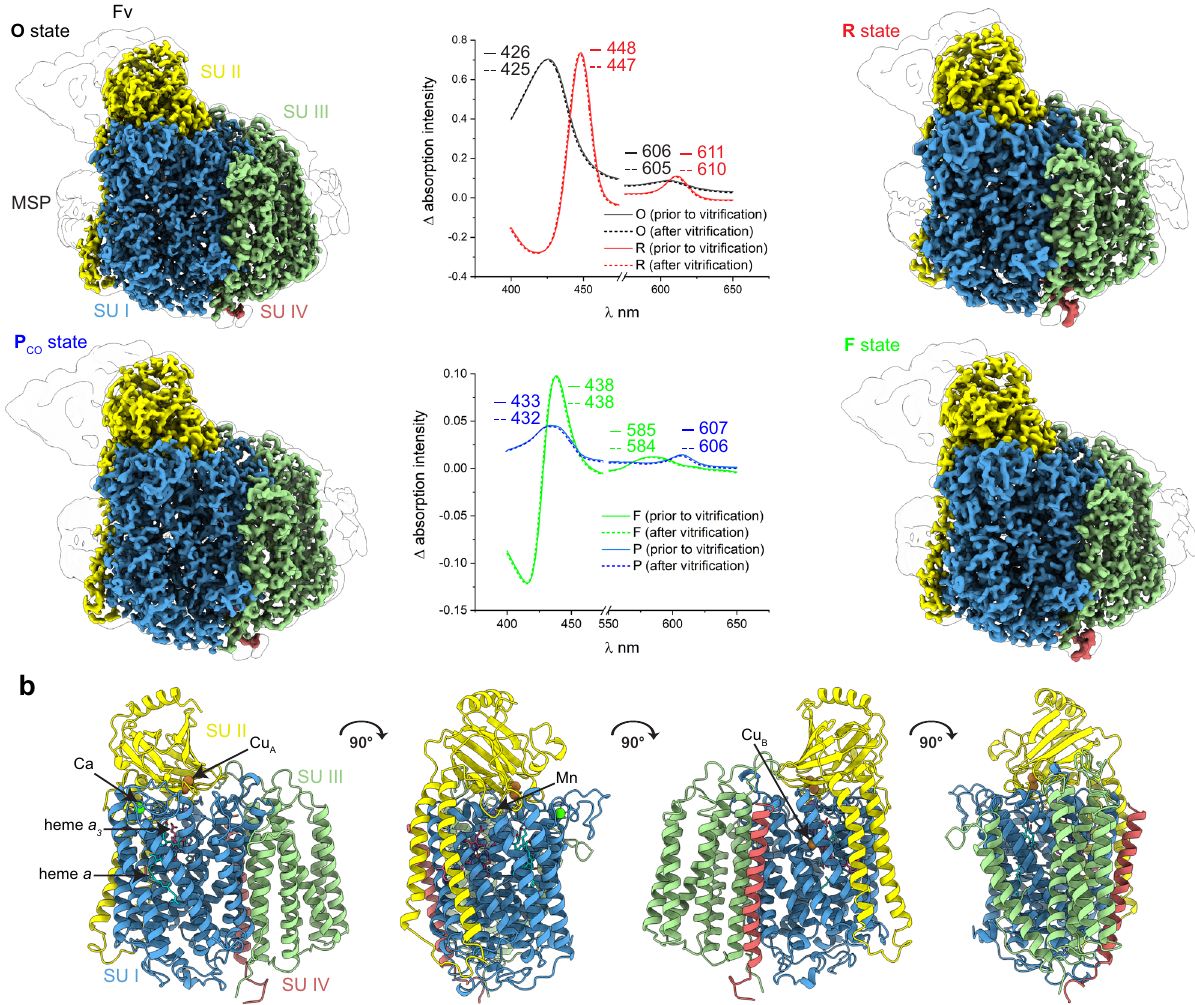
Fig. 2 Cryo-EM structure of the aa 3 C c O oxidase from P. denitri fi cans . a Surface representation of each intermediate state of the CcO at 1.9 Å ( O ), 2.6 Å ( R ), 1.9 Å ( P CO ), and 2.3 Å ( F ) resolution. Uv/visible absorption spectra were individually and consistently recorded (intermediate state minus O -state). The illustrated map densities are fi ltered to equal contour levels of 1. b Ribbon representation of all four subunits with corresponding cofactors of the C c O. Color scheme: SU I, blue; SU II, yellow; SU III, green; SU IV, red. The antibody fragment (Fv) and membrane scaffold protein (MSP) are shown as a white